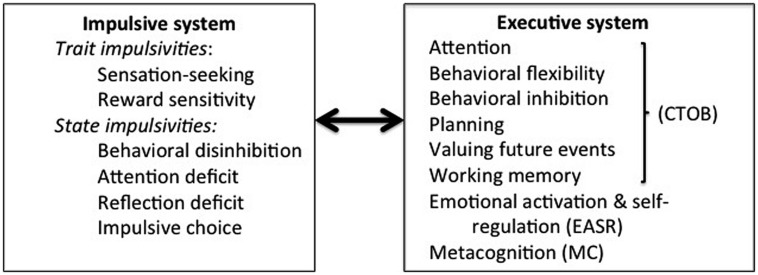
Competing Neuro-behavioral Decision Systems (CNDS). This depiction shows the interaction of the impulsive and executive systems which are delineated in terms of the components as identified by Bickel et al. (2012b).